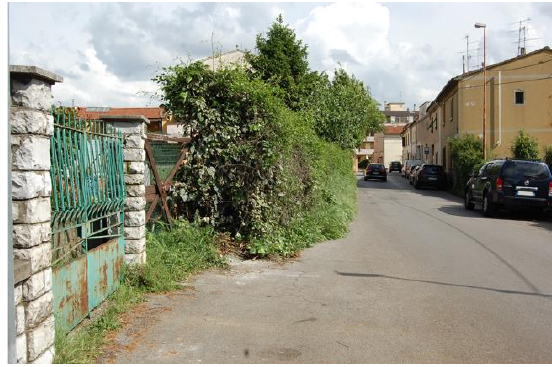
Figure 1. Spontaneous vegetation overruns the street